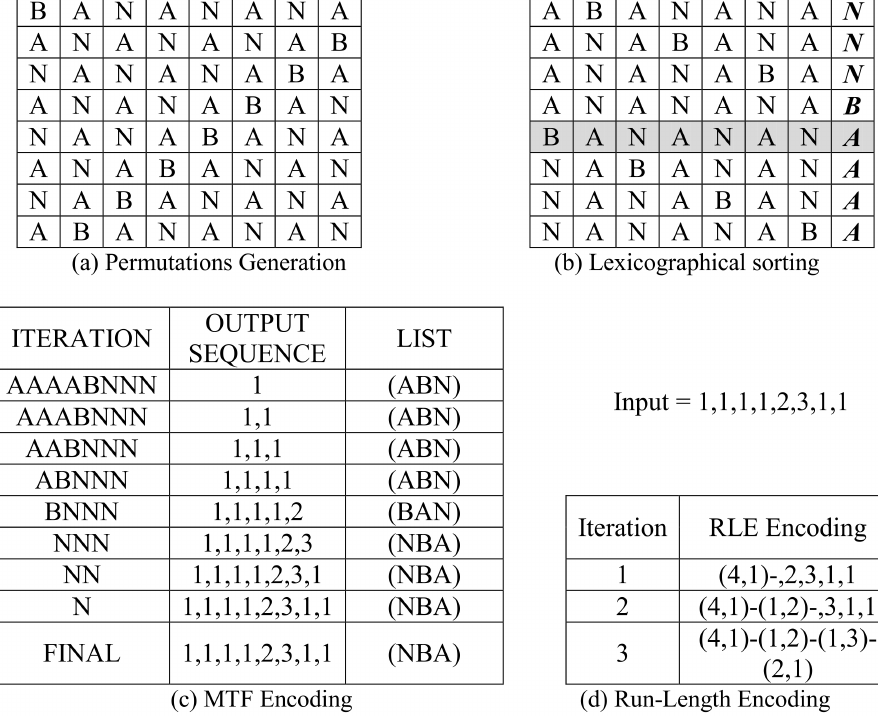
Figure 2. ( a ) Generated permutations from string ( b ) Permutations sorted with the final column containing the output string ( c ) M-Term Pursuit (MTF) encoding of string followed by Run-Length Encoding (RLE) in ( d